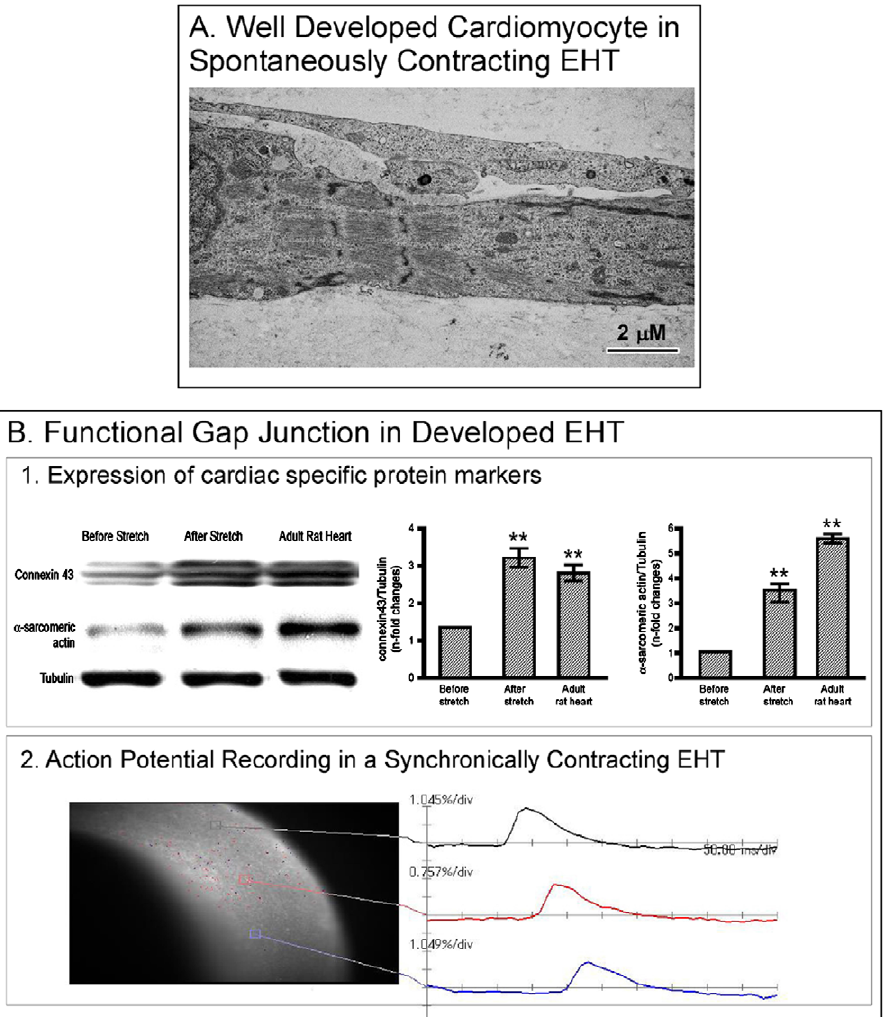
Figure 2. Characterization of the fully developed EHT. Samples were collected for electron microscopy (A) and western blotting (B1) after mechanical stretching. Tubulin was used as a loading control. Densitometry analysis was perfomed as explained in the methods. **P , 0.001 versus before stretch. For optical mapping (B2), The EHT was loaded with voltage sensitive dye and images were captured with a CMOS-based high speed and high resolution optical mapping